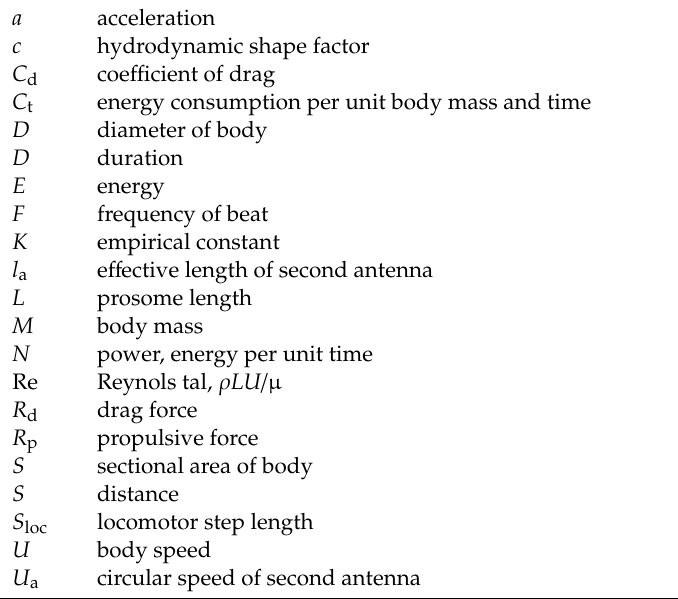
Table 1. List of